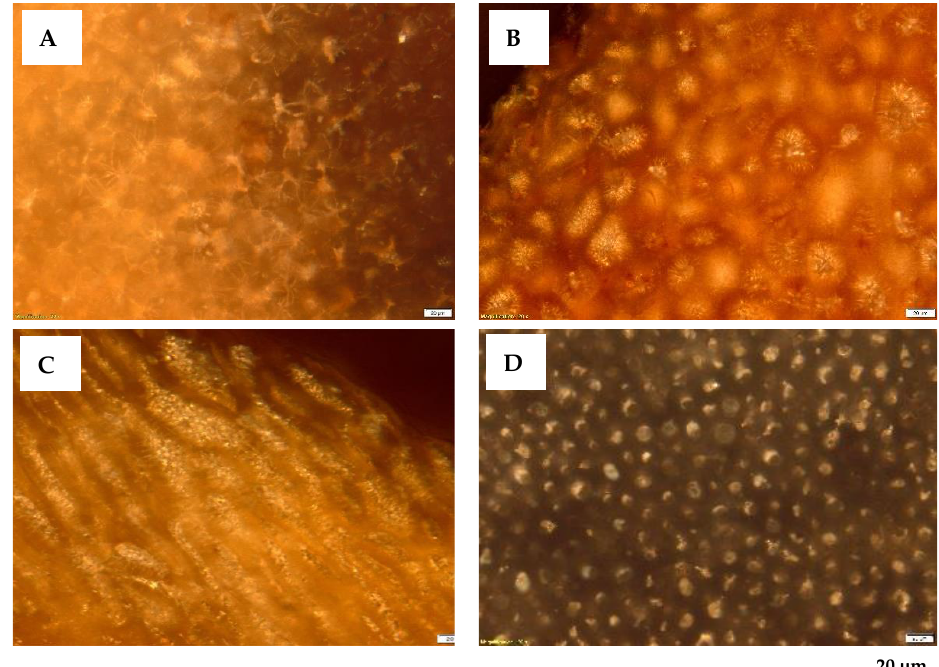
Figure 2. Photomicrographs of biomass wastes. Reflected light, immersion, 200×: ( A ). Walnut shells. ( B ). Peach kernels. ( C ). Apricot kernels. ( D ). Olive kernels.